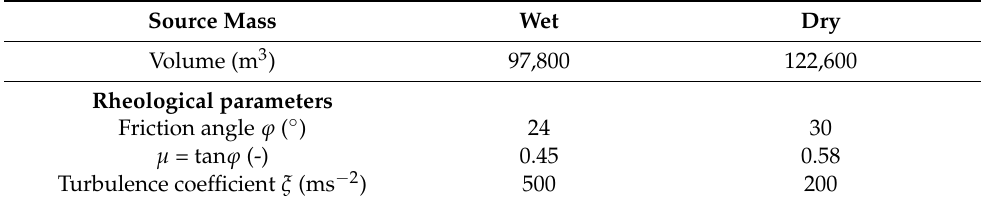
Table 5. Rheological and numerical parameters adopted in the propagation simulation in wet and dry